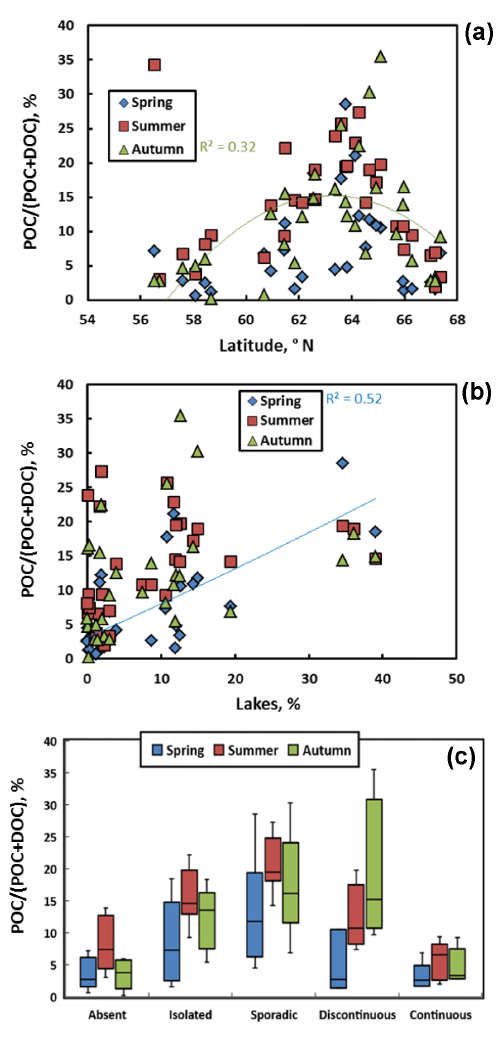
Figure 5. Fraction of particulate OC of total (dissolved + partic- ulate) form plotted as a function of latitude (a) , lake fraction on the watershed (b) and a box plot of fractions for five permafrost zones (c) . The solid lines in (a) and (b) represent a second-degree polynomial ( a : autumn) and linear ( b : spring) fitting of the data, with regression coefficients equal to 0.32 and 0.52,